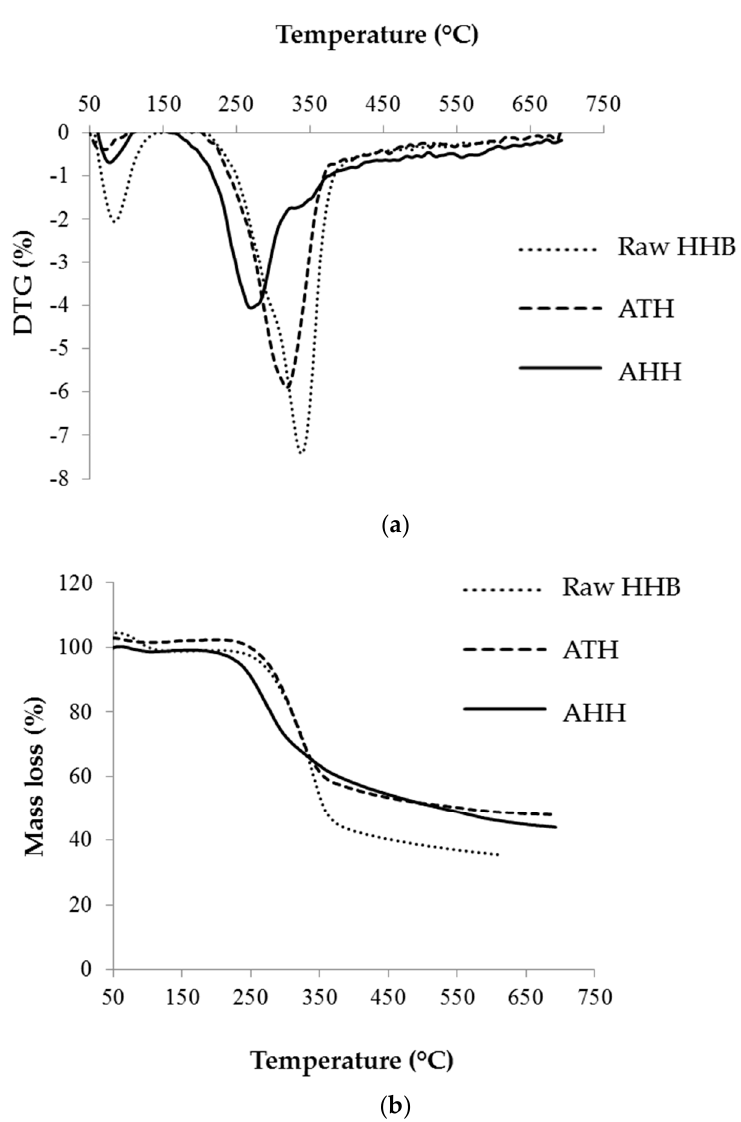
Figure 4. Thermal degradation of raw and treated HHB. ( a ) DTG and ( b ) TG curve. Table 4. The onset of pyrolytic degradation and decomposition peak of